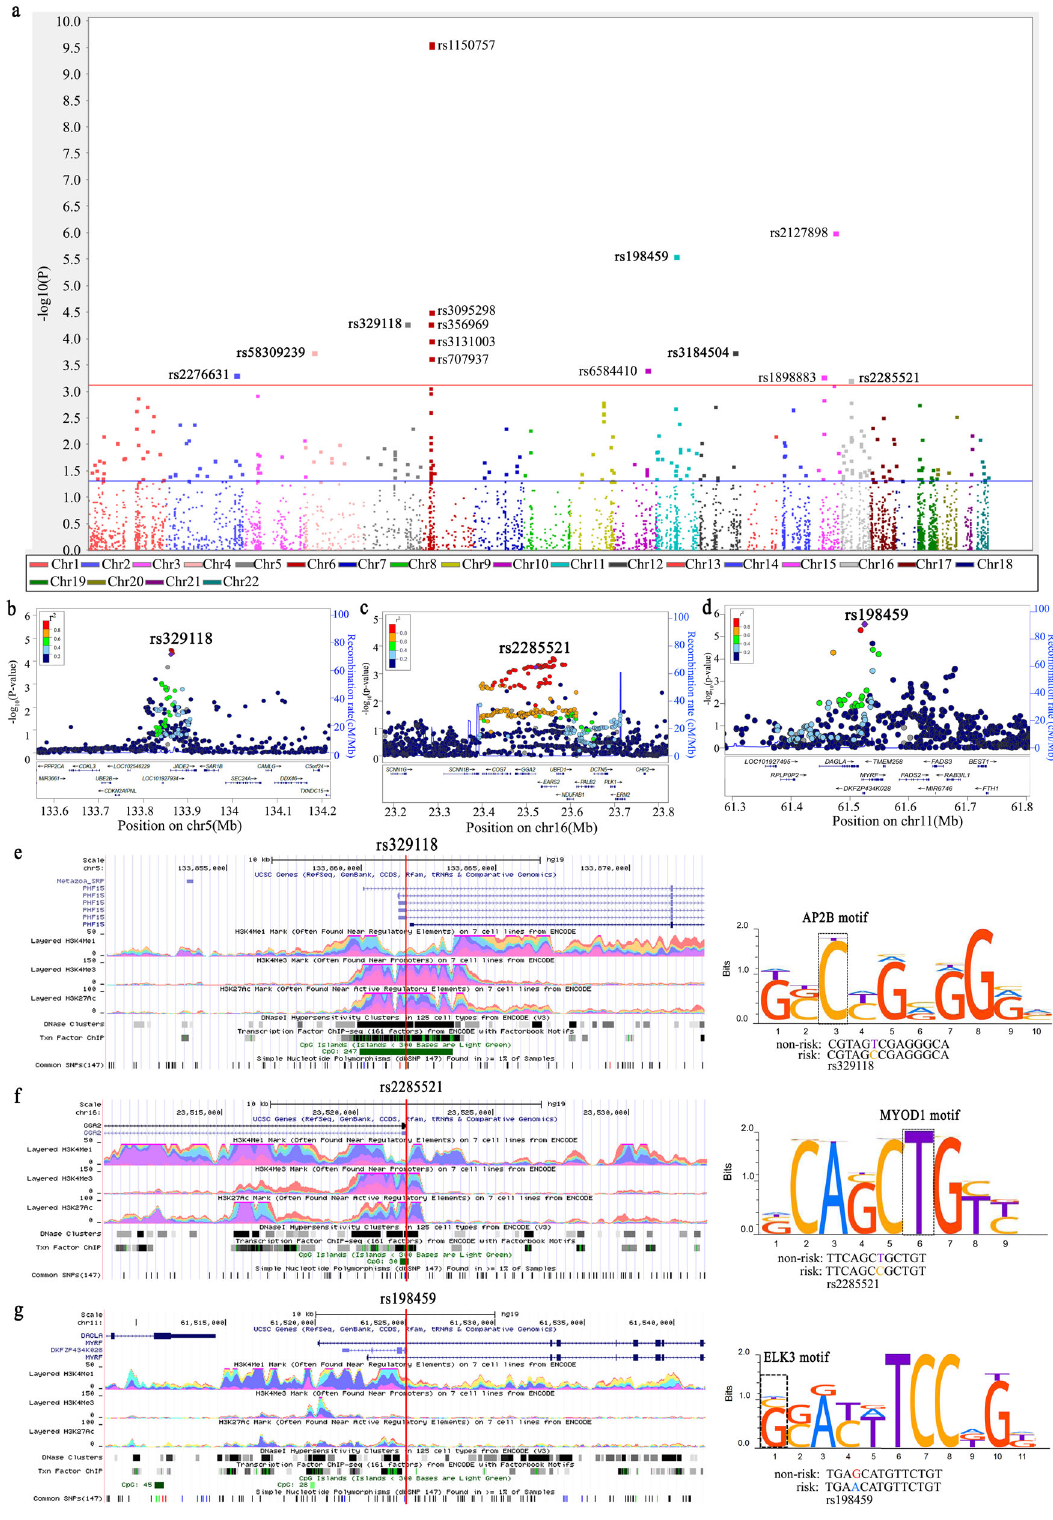
= 0.92 – 0.96, P = 8.80 × 10 − 9 ], while two other SNPs were associated with a signi fi cantly increased risk of lung cancer ( GGA2 rs2285521 C>T: OR = 1.08, 95% CI = 1.05 – 1.11, P = 4.43 × 10 − 8 and MYRF rs198459 G>A: OR = 1.07, 95% CI = 1.04 –